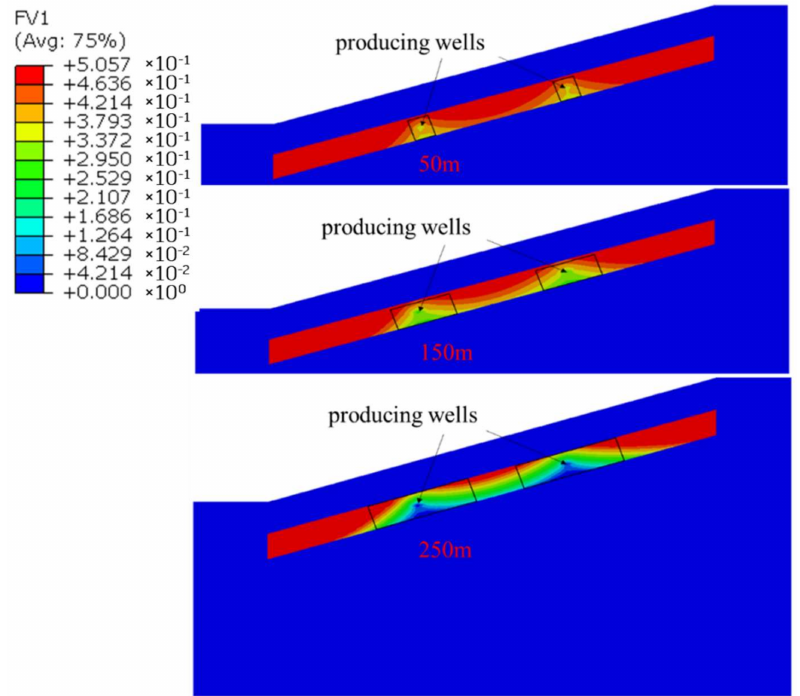
Figure 3. Distribution of NGH saturations corresponding to different decomposition ranges.